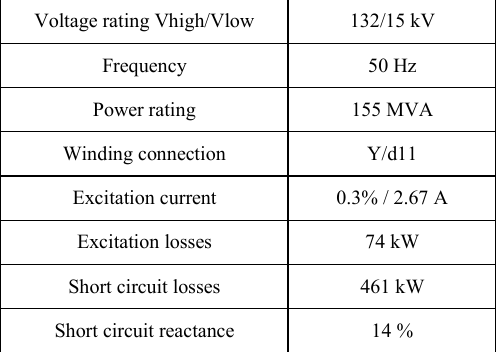
TABLE 1: T HE NAME - PLATE DATA OF THE SIMULATED POWER TRANSFORMER